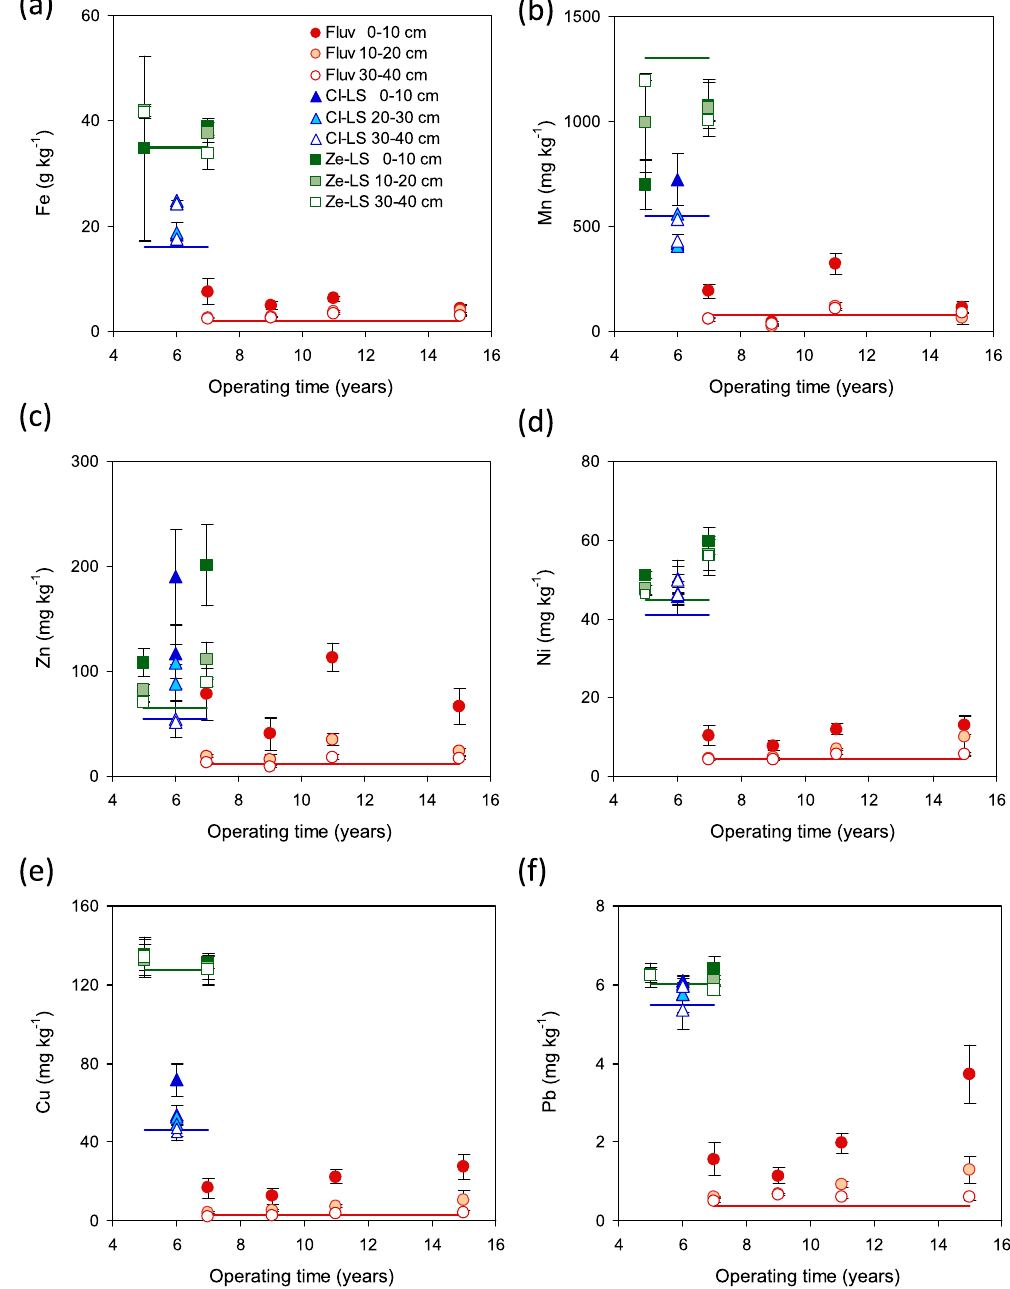
Figure 2. Concentrations of ( a ) Fe, ( b ) Mn, ( c ) Zn, ( d ) Ni, ( e ) Cu and ( f ) Pb at different depths of fluviatile sand (Fluv) and clinopyroxene- (Cl-LS) and zeolite-dominated lava sand (Ze-LS)-based constructed wetland profiles of different operation time. Solid lines show the baseline concentrations of metals in the starting materials of both lava sands and in the deepest layers of fluviatile sand based constructed